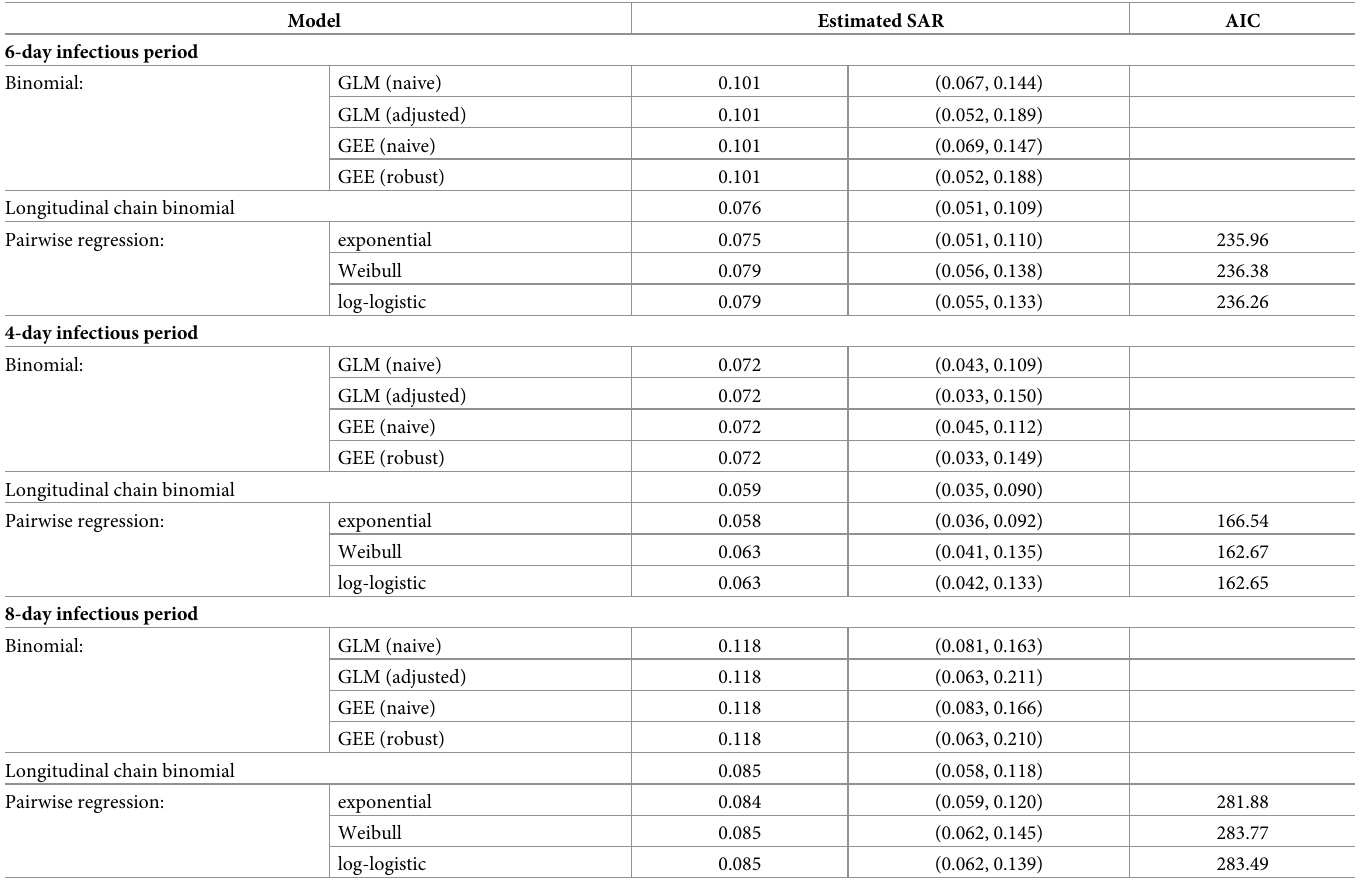
Table 3 shows point estimates and 95% confidence intervals for the household SAR. The point estimates for all binomial models are identical. As expected, binomial models produce much higher estimates than the chain binomial or pairwise regression models. Adjustment for clustering produced wider confidence intervals, with very similar results in the binomial GLM Table 3. Estimates of the household SAR with 95% confidence limits and Akaike information criterion (AIC) for pairwise regression models.